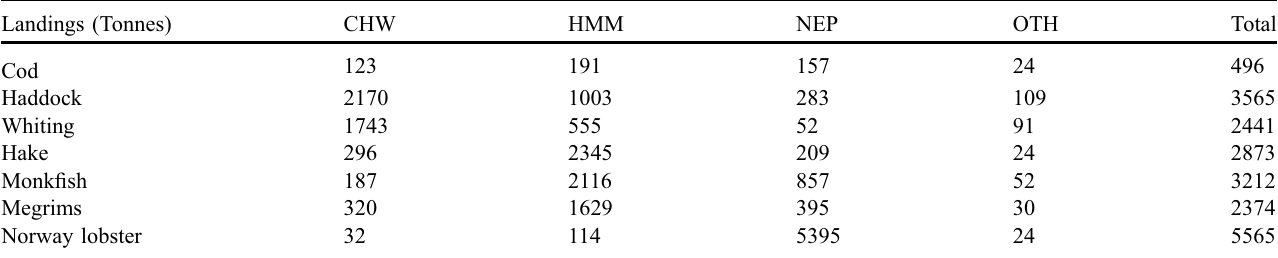
Table A.2. Total landings (tonnes) by the polyvalent general fl eet segment þ 18m of the main species within each fi shery (cod, haddock, whiting (cid:2)